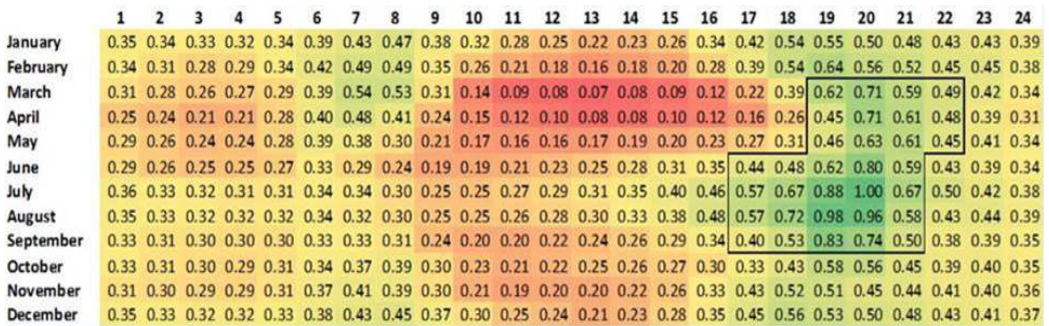
Figure 3. An illustration of a typical 12 × 24 matrix provided by the utility representing the normalized value of energy during different times over the year with the highlighted green representing the target period window. Source: First Solar PVS Analytics.